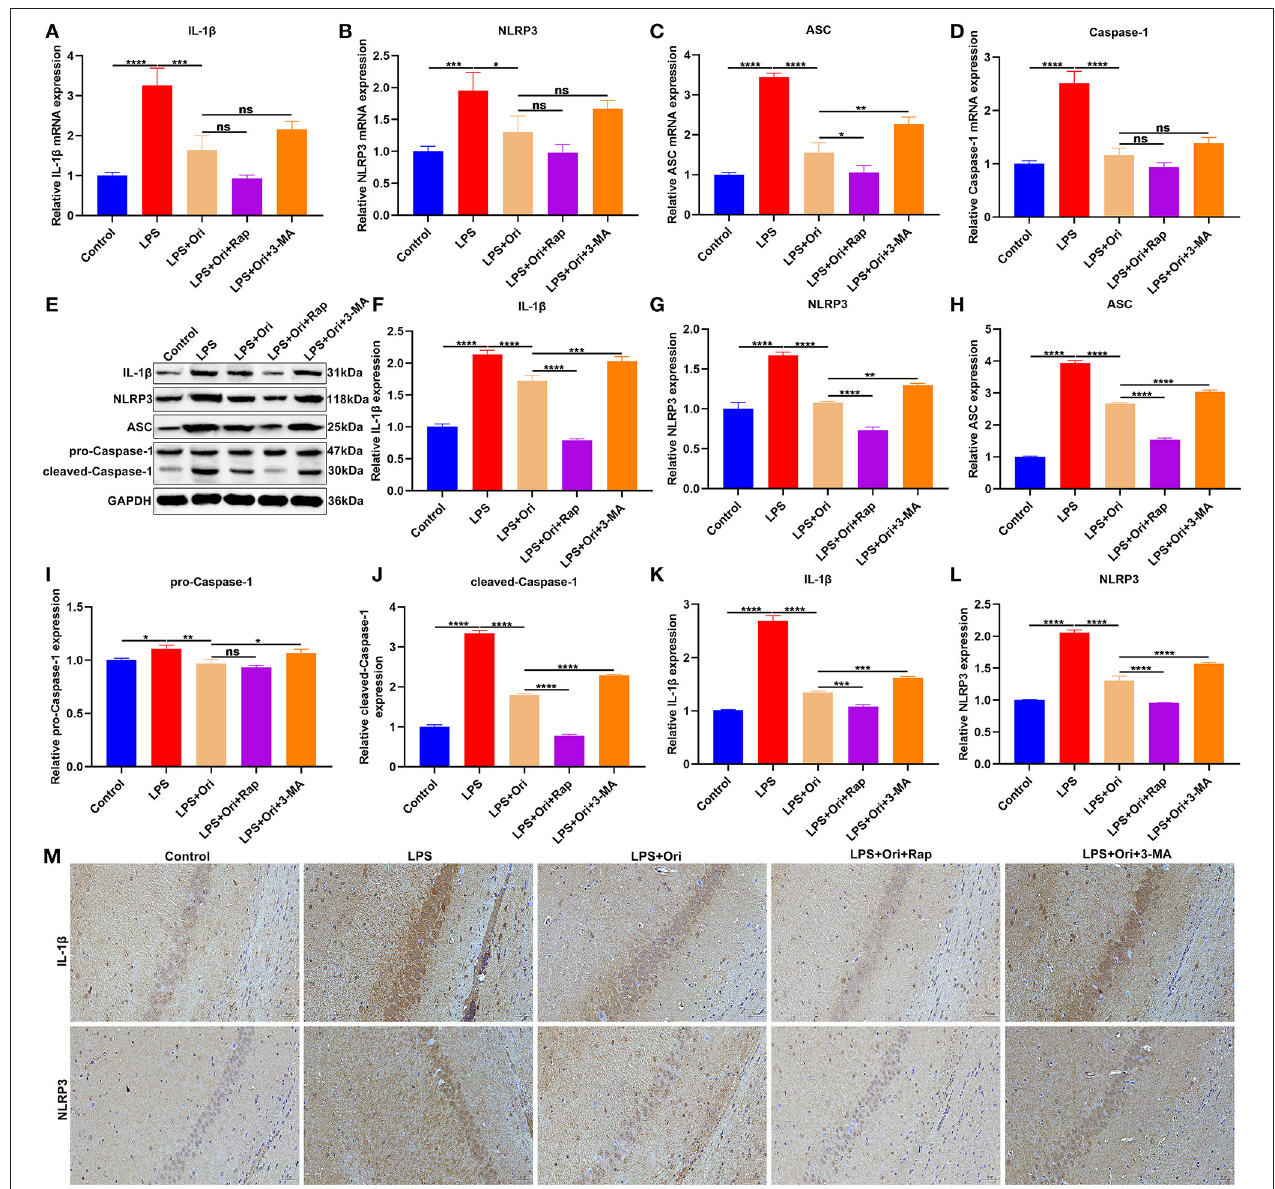
FIGURE 3 | Effects of Ori, autophagy agonist Rap and autophagy inhibitor 3-MA on NLRP3 inflammasome in LPS-induced depression mouse models. (A–D) RT-qPCR for examining the relative mRNA levels of IL-1 β , NLRP3, ASC as well as Caspase-1 in the hippocampus in each group. (E) Representative blots showing IL-1 β , NLRP3, ASC, pro-Caspase-1, and cleaved-Caspase-1 in the hippocampus. (F–J) Quantitative analysis of IL-1 β , NLRP3, ASC, pro-Caspase-1, and cleaved-Caspase-1 expression according to the western blotting results. (K–M) IHC showing the expression IL-1 β and NLRP3 in the hippocampus. Magnification, 200 × (50 µ m). N = 6 each group. P values were calculated with ANOVA followed by Turkey’s post-hoc test. Ns, not significant; * p < 0.05; ** p < 0.01; *** p < 0.001; **** p < 0.0001.